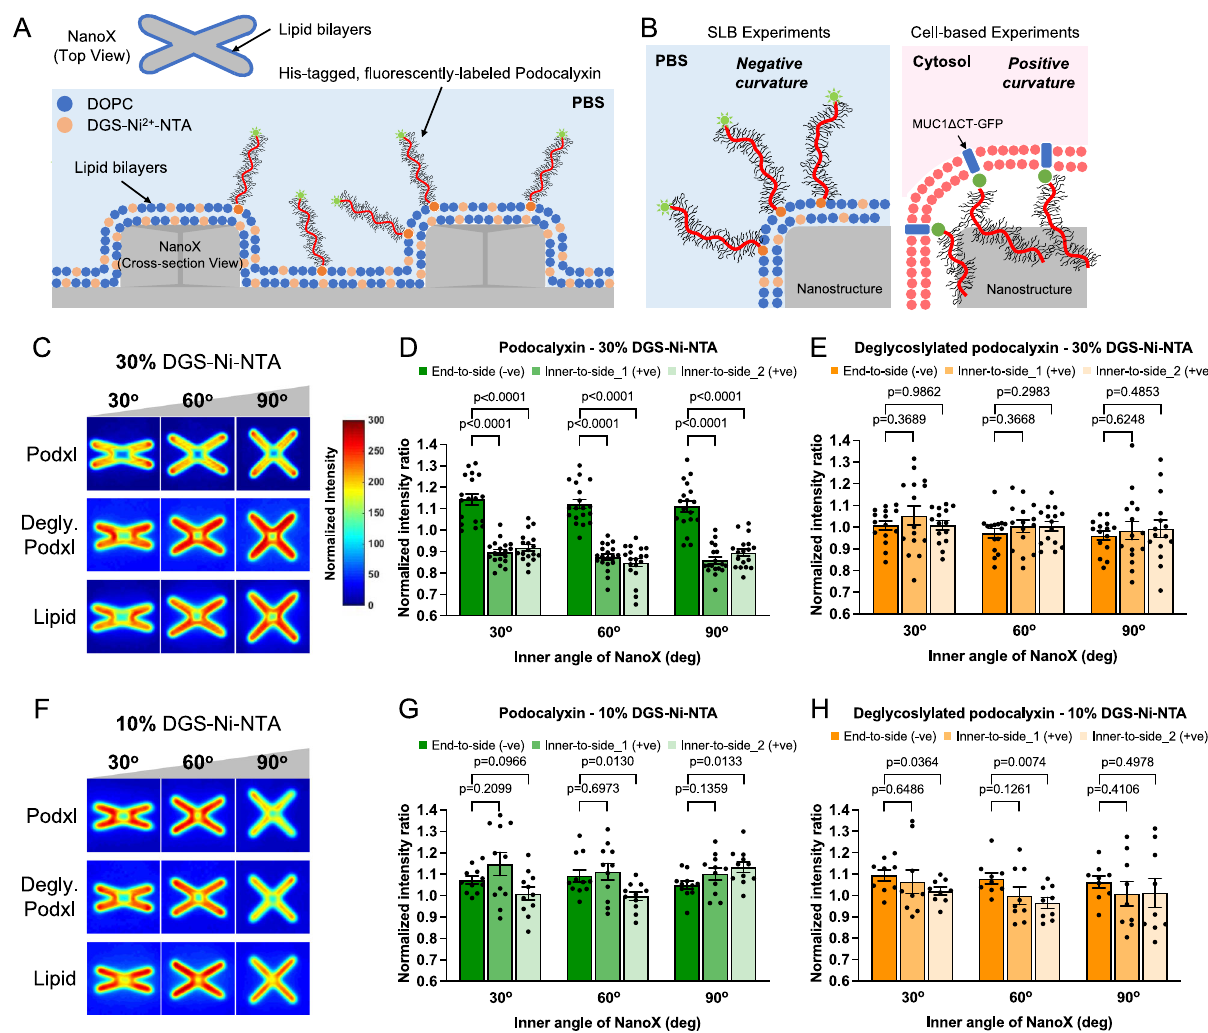
Fig. 5 Large glycoproteins avoid positive membrane curvatures in vitro. A Schematic illustration of supported lipid bilayers (SLB)-based arrays employed to study the in vitro curvature preference of a mucin-like glycoprotein, Podocalyxin (Podxl). B Cartoons elucidating the opposite membrane curvature for the distribution of mucin glycocalyx proteins on lipid bilayers vs. in the cell-based experiments. C Heatmaps show the spatial distributions of Podxl, deglycosylated Podxl, and lipid bilayers around the nanoXs (with 30% DGS-Ni-NTA). D , E Quanti fi cation of end-to-side (re fl ecting the preference for negative curvature) and inner-to-side ratios (re fl ecting the preference for positive curvature) of ( D ) Podxl and ( E ) deglycosylated Podxl on gradient nanoXs arrays of three selected inner angles. Podxl preferentially accumulates at negatively-curved membranes at the ends of nanoX arms. The lipid bilayers were doped with 30% DGS-Ni-NTA (see Supplementary Table 5A, B for the detailed statistics). F Heatmaps show the spatial distributions of Podxl, deglycosylated Podxl, and lipid bilayers around the nanoXs (with 10% DGS-Ni-NTA). G , H Quanti fi cation of end-to-side and inner-to-side ratios of ( G ) Podxl and ( H ) deglycosylated Podxl on the lipid bilayers doped with 10% DGS-Ni-NTA (see Supplementary Table 5C, D for the detailed statistics). All ratios are normalized against the rhodamine-lipid signals. Welch ’ s t -tests (unpaired, two-tailed, not assuming equal variance) are applied for all statistical analyses in this fi gure. Error bars represent